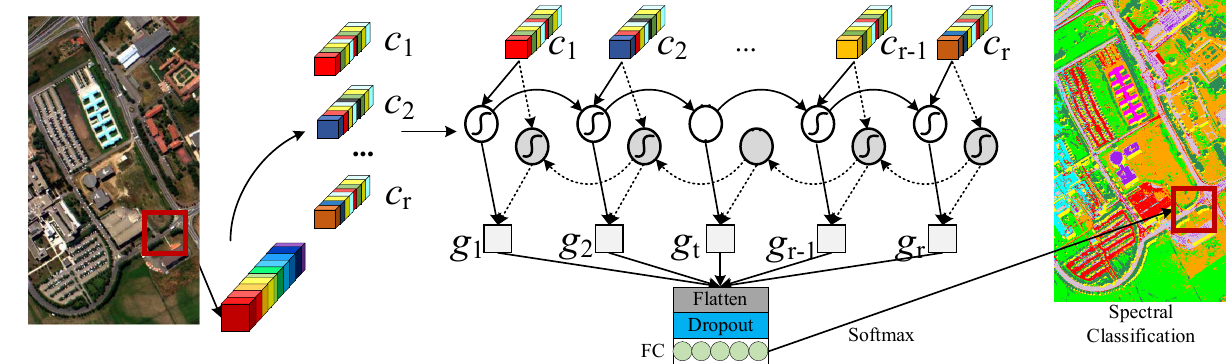
Figure 2 . Architecture of the proposed band grouping-based